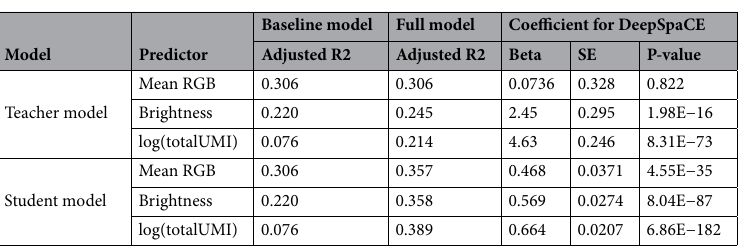
Table 1. Linear regression analysis. The table shows the adjusted R-squared value of the baseline model, adjusted R-squared value in the full model, and beta, SE, and P-value of coefficient for DeepSpaCE. The values were calculated using mean RGB values, brightness, and log(total UMI) in the teacher model and student 4